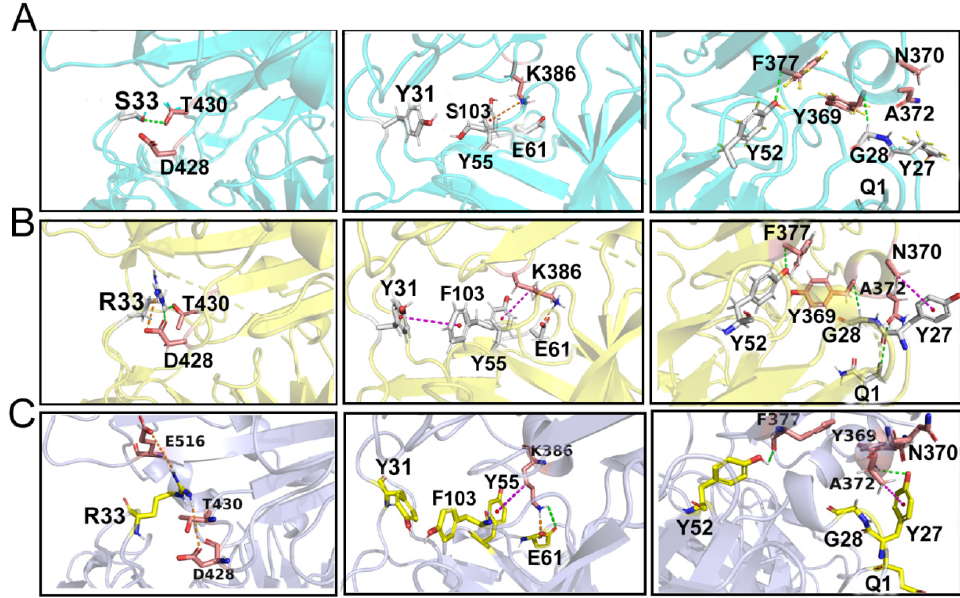
Figure 9. Hydrogen-bonded and hydrophobic interaction network analysis. Three secondary struc- tures ( α -helix2, β -sheet2 and β -turn3) on the SARS-CoV-2 RBD participated in non-covalent bonded interaction with the CDR regions of the antibodies. This specific hydrogen, electrostatic and hy- drophobic interaction of CR3022 SARS-CoV-2 RBD ( A , in cyan), S103F–S33R–RBD ( B , in yellow) and S103Y–S33R–RBD ( C , in purple) with IMGT number were represented by the green dashed line, gold dashed line and magenta dashed line, respectively.